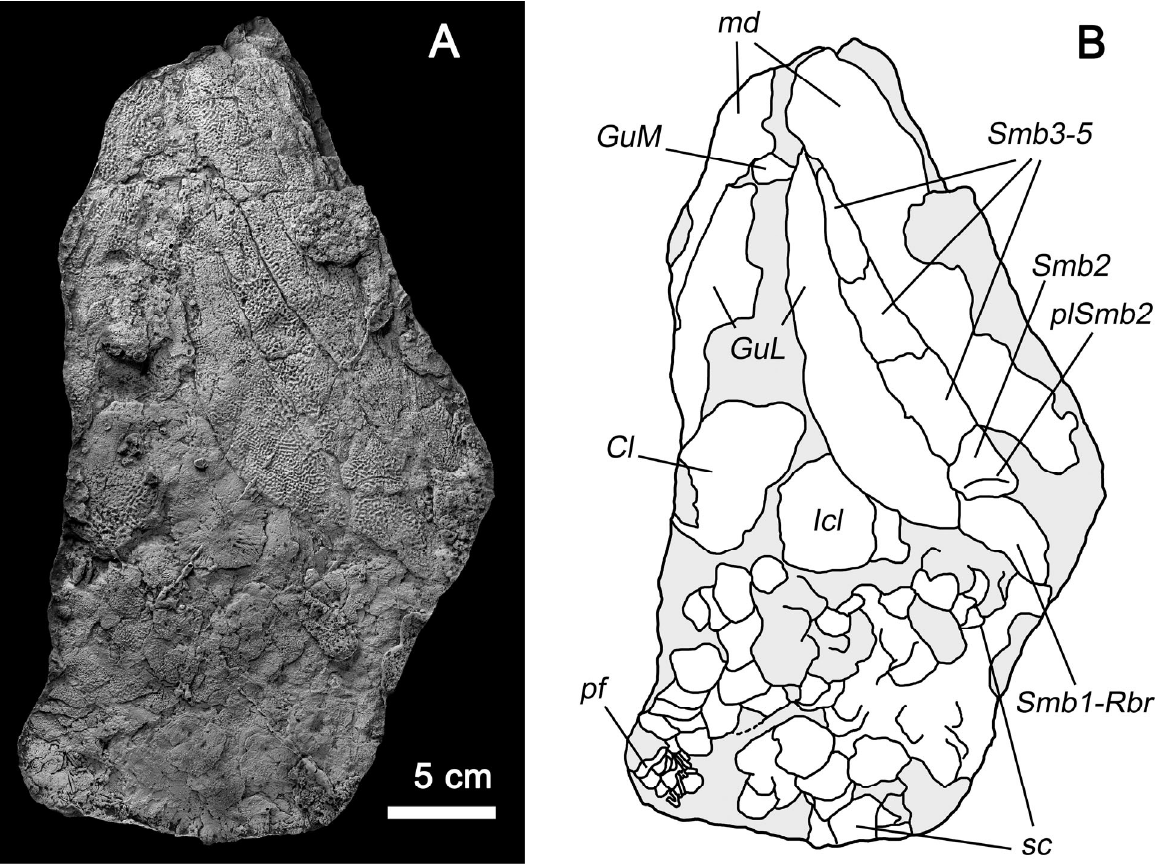
Fig. 5. Ventral side of the skull, shoulder girdle and squamation of Eusthenodon sp., PIN 2921/3270. Tula Region, Central Russia, right bank of the Bol ʹ shaya Mizgeya River, a local quarry approximately 1 km northwards from the Gorbachevo village. A , latex rubber cast; B , schematic explanatory drawing. Abbreviations: Cl , clavicle; GuL , lateral gular; GuM , median gular; Icl , interclavicle; md , mandible; pf , pectoral fin; plSmb2 , pit line on submandibular 2; Smb1-Rbr , submandibulo-branchiostegal element; sc , scale; Smb2, Smb3-5 ,